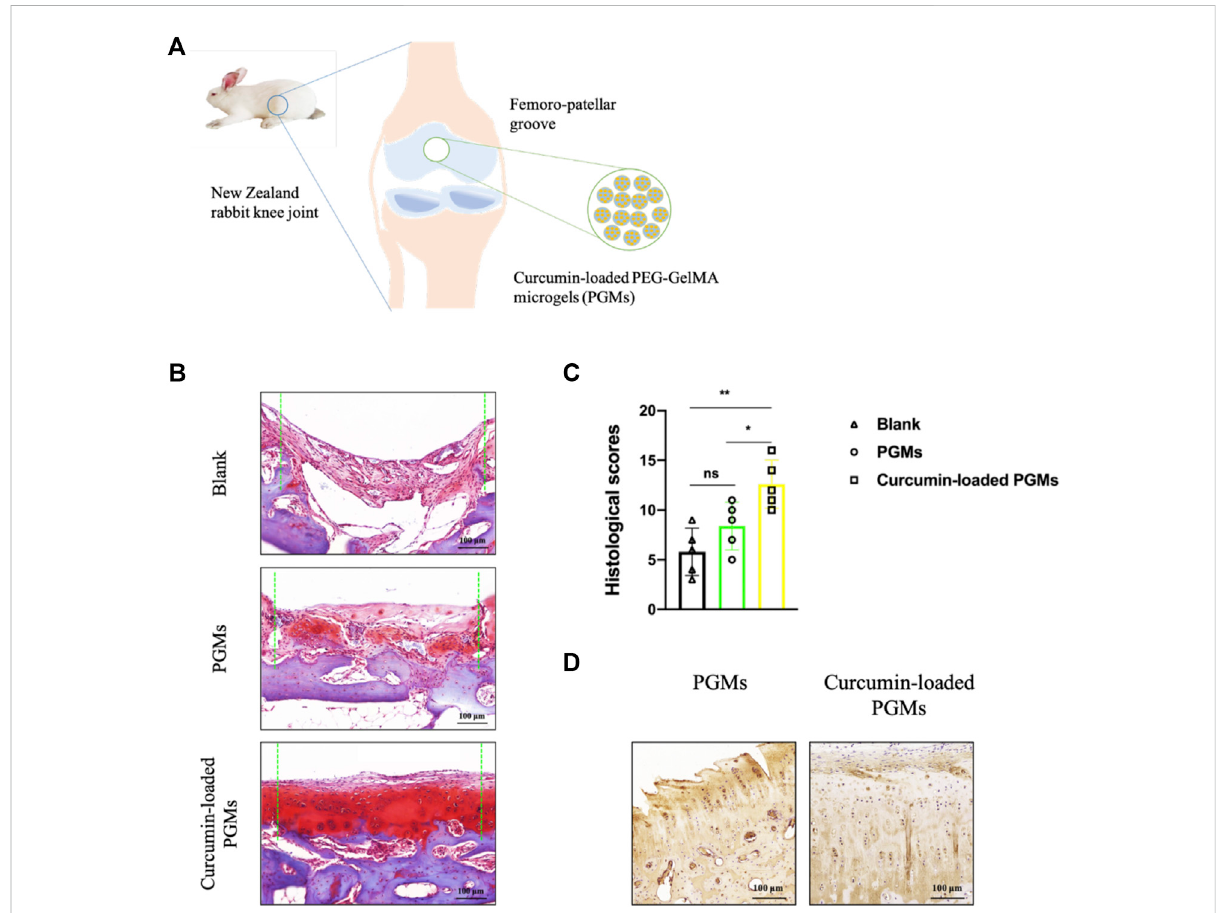
FIGURE 5 The amelioration of chondrocyte in fl ammation with curcumin-loaded PEG-GelMA microgel (PGMs). (A) Schematic of the implantation of curcumin-loaded PGMs for the repair of cartilage defects in a rabbit femoro-patellar groove. (B) The Safranin-O staining of the repaired cartilage tissuesinBlank,PGMsandcurcumin-loadedPGMsgroupsat8 weekspost-surgery.Scalebar=100 μ m. (C) Quanti fi cationofthehistologicalscores of cartilages under evaluation among Blank, PGMs and curcumin-loaded PGMs groups in Safranin-O staining results. (Mean ± SD; p p < 0.05, pp p < 0.01; n = 5 per group). (D) The immunohistochemical staining of Collagen II in the repaired cartilage between PGMs and curcumin-loaded PGMs groups at 8 weeks post-surgery. Scale bar = 100 μ